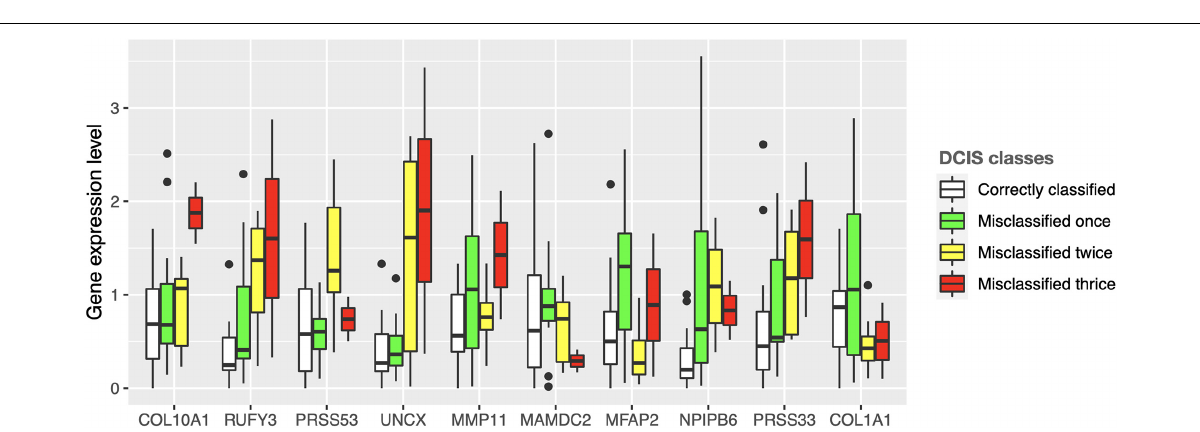
FIGURE 4 | Expression values of the 10 genes across the DCIS cases repeatedly misclassified as IBC. The bars show absolute deviance from the median expression level of the correctly classified DCIS class for each gene. The median level of the correctly classified DCIS class was subtracted from the other classes to better show differential expression levels. Supplementary Figure 10 shows the expression differences before subtracting the median level of the correctly classified DCIS